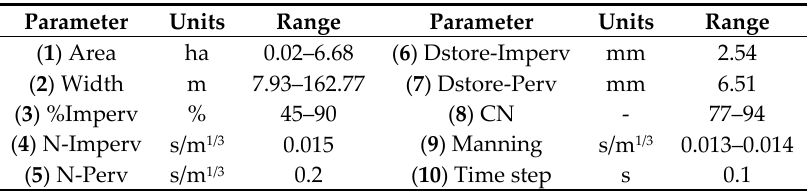
Table 1. Key Model Parameters.